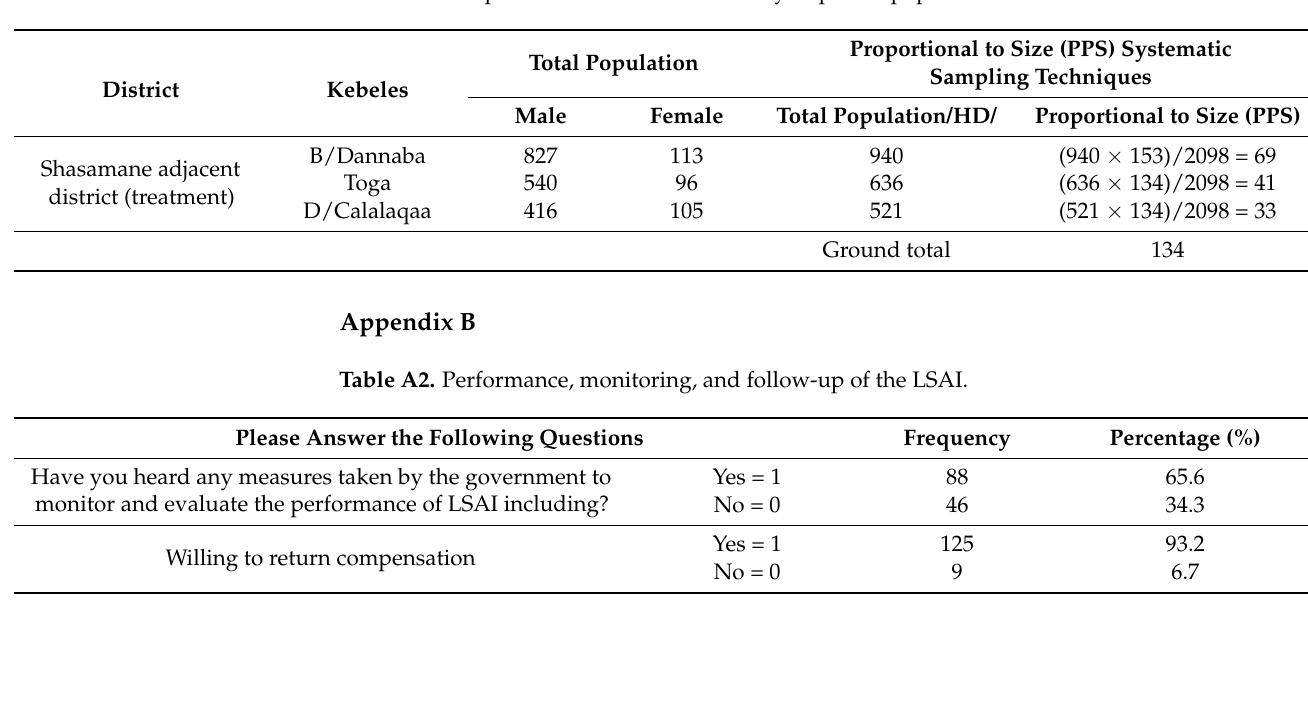
Table A1. Sample households from a directly impacted population.